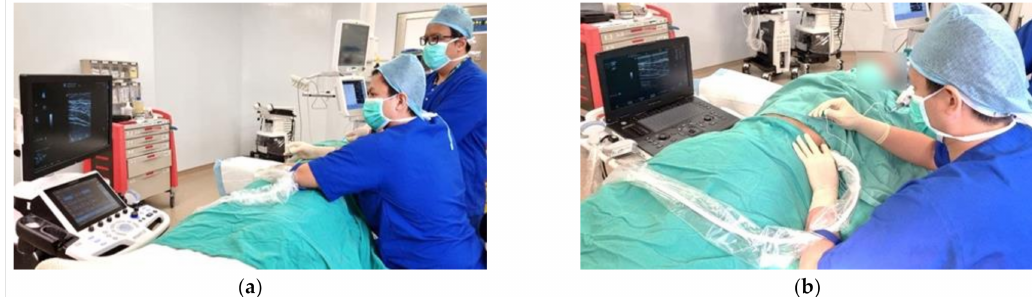
Figure 5. ( a ) Improper position: The operator is viewing the ultrasound monitor with a significant neck rotation to the left. ( b ) Proper position: The operator is viewing the ultrasound monitor straight ahead with a slight neck flexion. Trunk bending and twisting causing back pain and disc disease are avoided by keeping the patient and ultrasound aligned on the same visual axis and adjusting the patient bed, trolley or operating table [29] (Figure 6a,b).